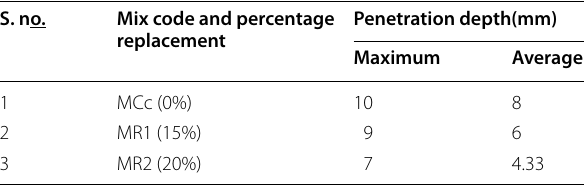
Table 7 The average and maximum water penetration depth of the optimum mixes